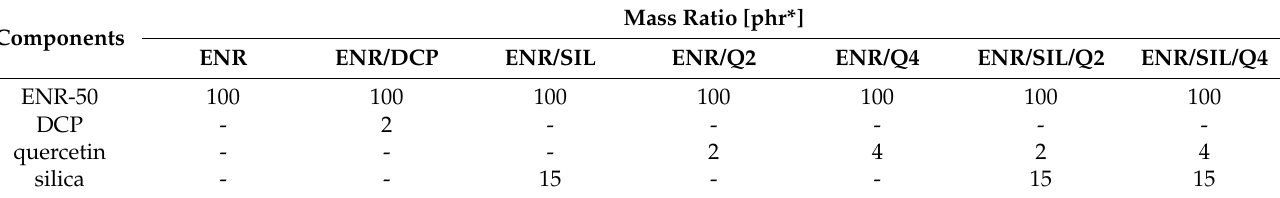
Table 2. Composition of tested ENR-50-based